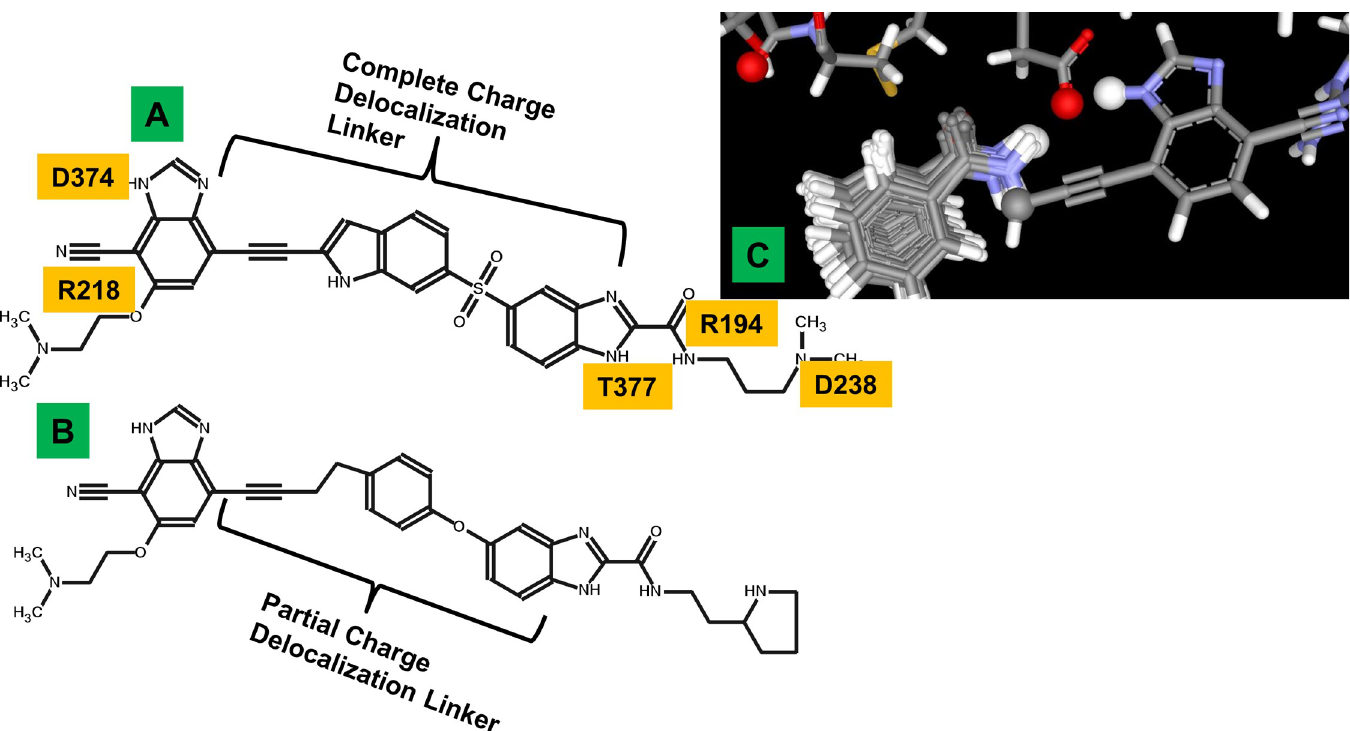
Fig 13. Complete vs. partial charge delocalization linkers. The molecule with a complete delocalization linker (A) was designed based on the benzaldehyde (C) and indole merging with acetylene predicted by SACP to also pincer D374. This linker strategy is based on connecting sites on the protein in a way that enables charge delocalization from D374 to R194. The partial delocalization linker (B) is designed to make the same interactions with PCSK as (A), so any difference in function provides evidence supporting our end-to-end charge delocalization conjecture.